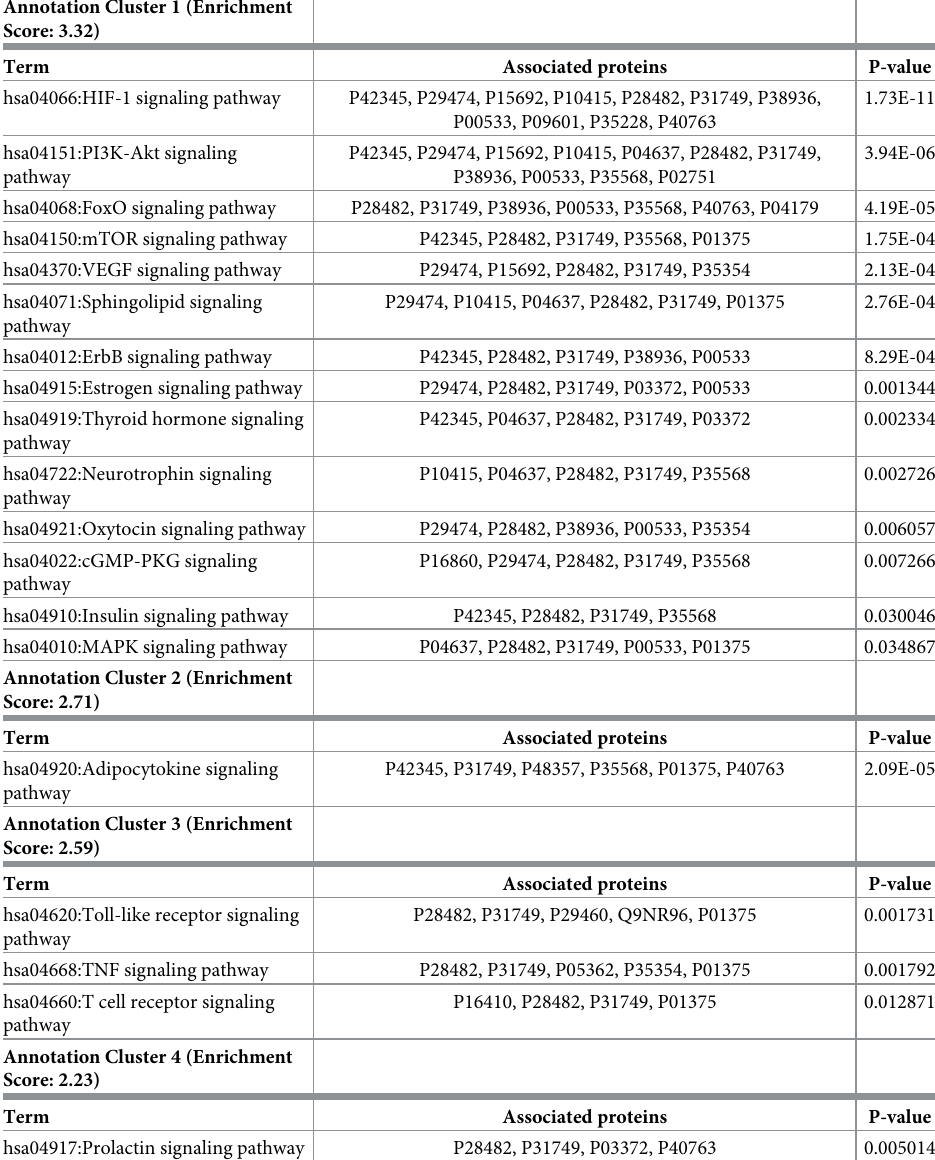
Table 7. Some of the significantly enrichment signaling pathways associated with